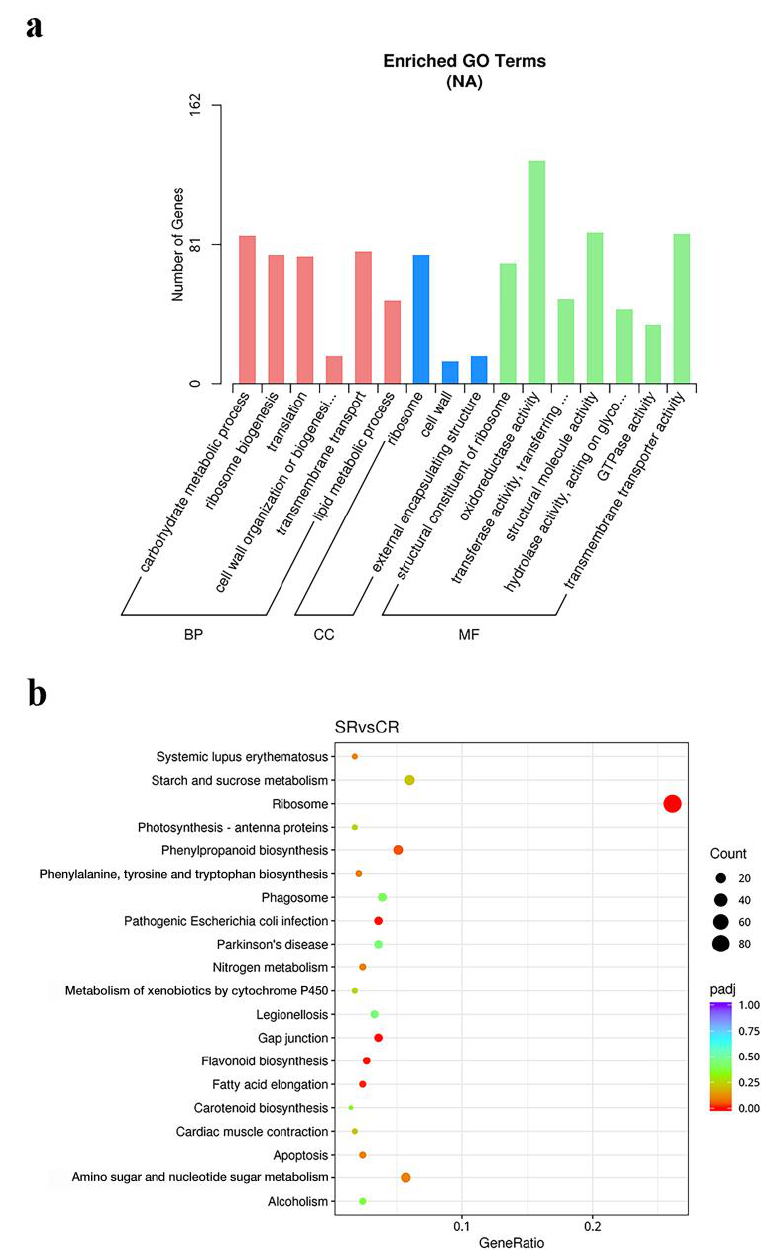
Figure 3. GO ( a ) and KEGG ( b ) pathway enrichment of differentially expressed genes in water lily roots from control vs. 150 mM NaCl